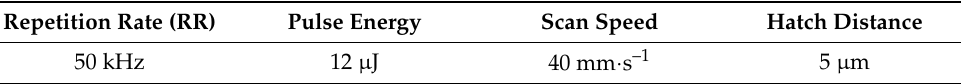
Table 1. Laser micromilling parameters .